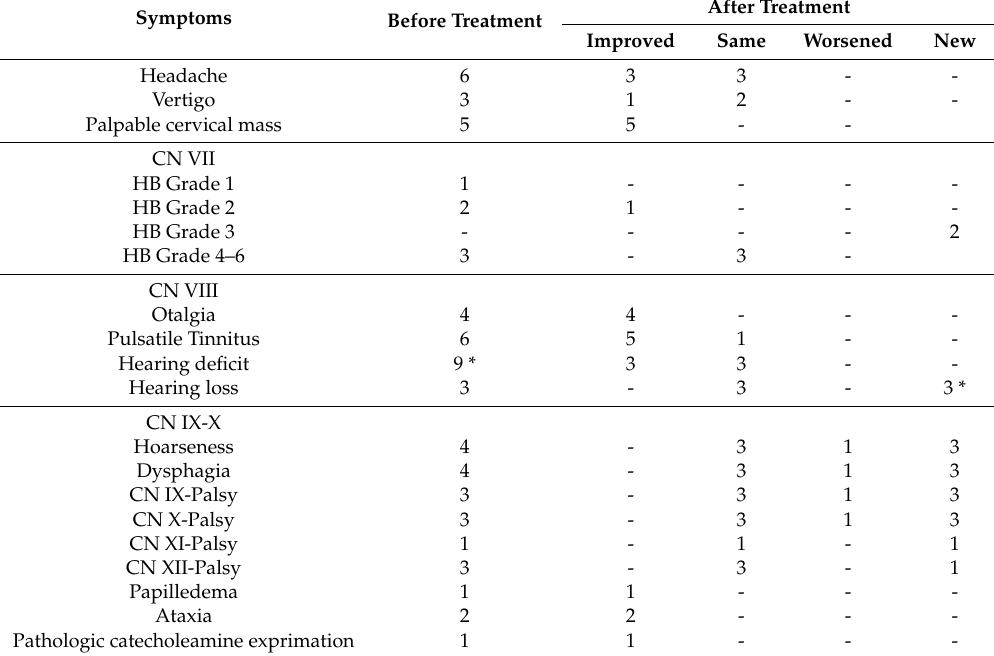
Table 3. Pre- and postoperative clinical data of 22 patients with